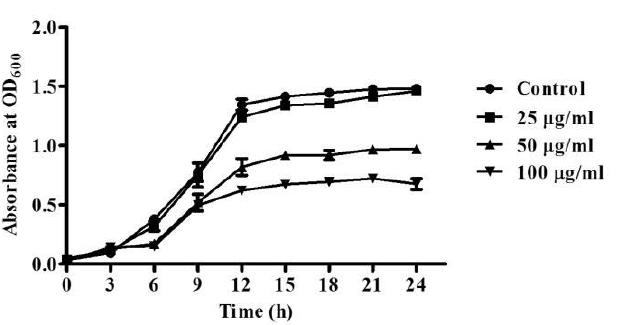
Figure 2: The growth of E. coli 0157: H7 in Luria broth medium in the presence or absence of cell-free culture supernatant at different concentrations were evaluated and measured the OD at 600 nm for 24 hours at 37°C To support our findings further, we next used acridine orange/ethidium bromide staining. Acridine orange is an intercalating dye which stains both live and dead bacterial cells, however, the loss of cell membrane integrity allows ethidium bromide to stain the nucleated cells only (Hameed et al., 2016). As depicted in Figure 3, live bacterial cells appeared in green color due to acridine orange staining, whereas dead cells appeared in red color due to the loss in membrane integrity of E. coli 0157: H7 cells. The ratio of red fluorescent was comparatively higher after treatment with cell-free culture supernatant (100 μg/m L) than before treatment (control sample).